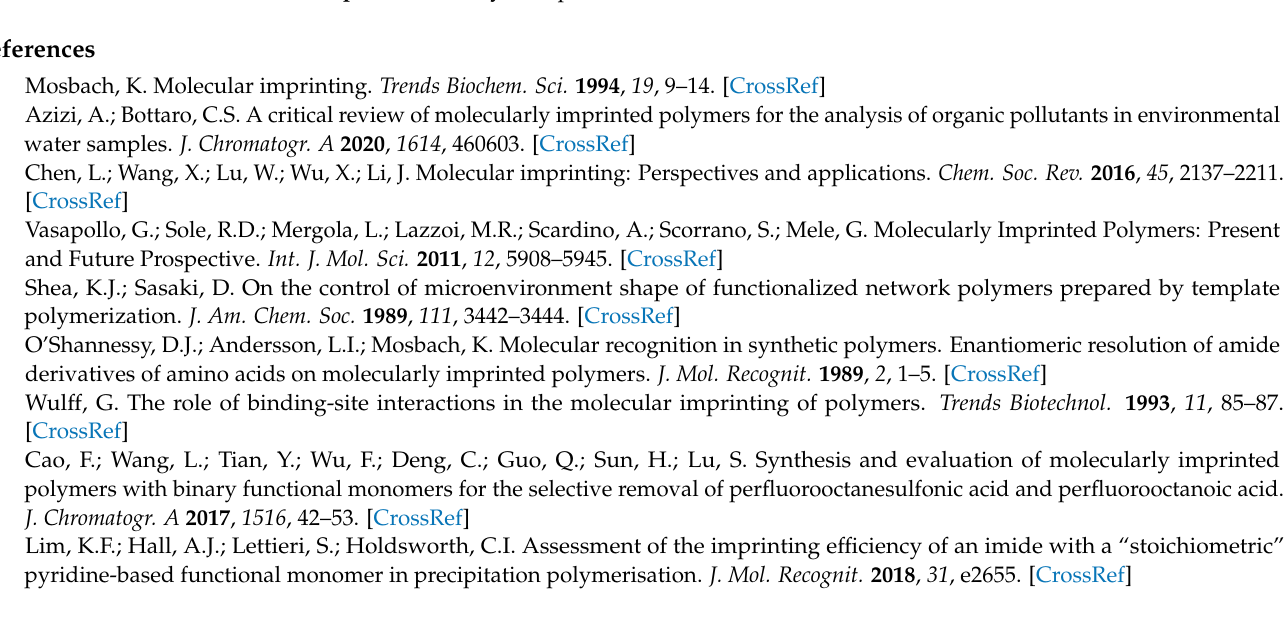
quantitative analysis. Figure S6: 1 H-NMR spectra of (a) 2 mM pindolol (PIN), (b) 2 mM atenolol (ATL), and (c) 2 mM propranolol (PNL), with 10 mM 2,4-dinitrophenol (DNP) in DMSO-d6 as external standard in a 5 mm probe coaxial